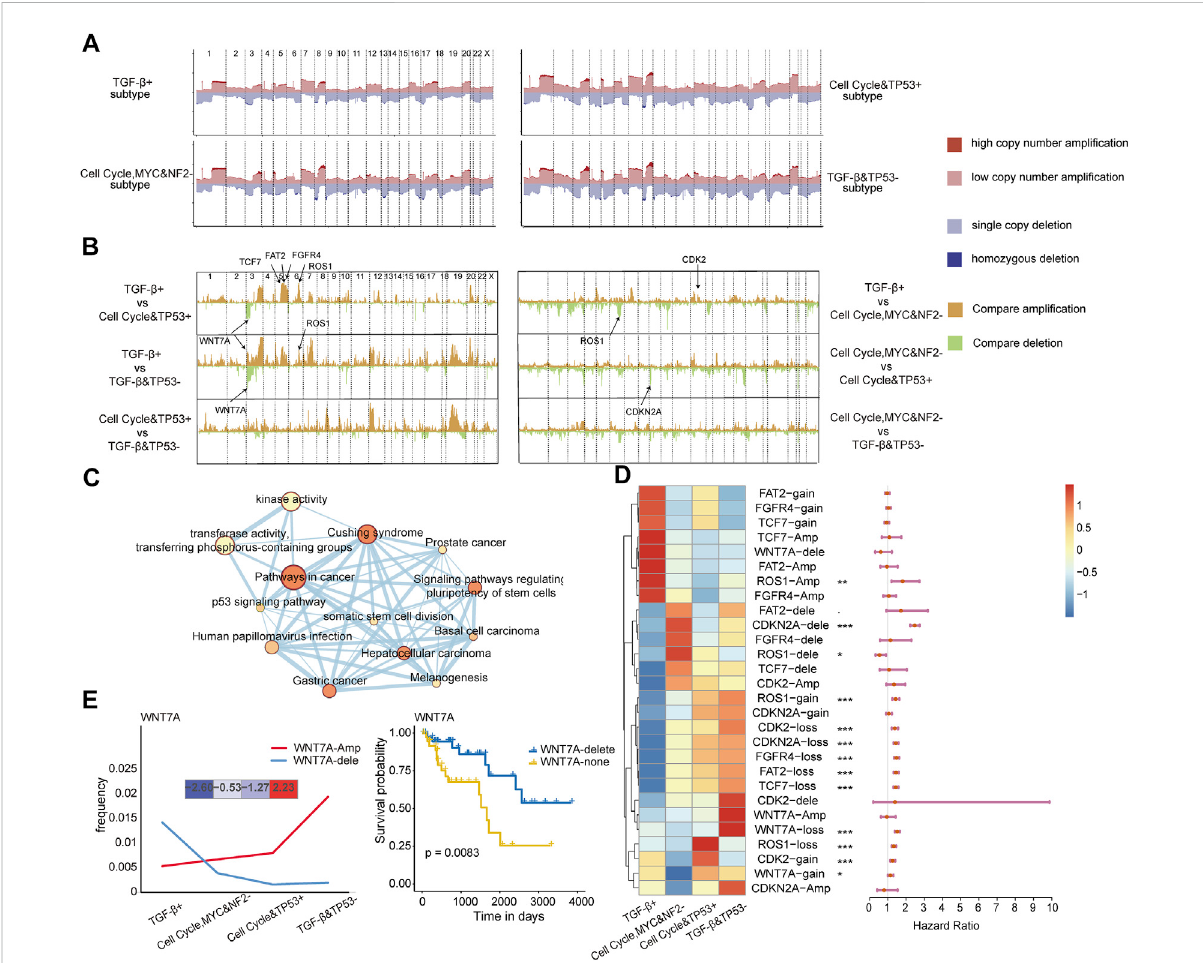
FIGURE 4 (A) Somatic CNA frequency of individual genes in each subtype plotted along the chromosomes. (B) Comparisons of somatic CNA between subtypes with − log10 FDR plotted along the chromosomes (Fisher ’ s exact test). (C) Interaction of the enriched pathways. The size represents the number of genes, and the color represents the p -value. (D) Differences in copy number variation across the four subtypes of the four copy number variation states of the seven genes and their relationship with the prognosis. (E) Changes in the number of ampli fi ed and deleted samples of WNT7A in the four subtypes; the expression of WNT7A in the four subtypes (left) and the difference in survival between the two categories